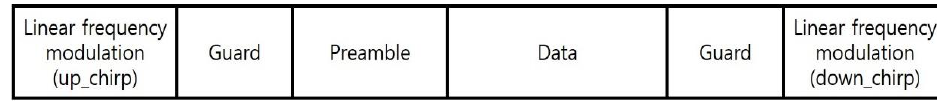
Figure 9. The Packet structure in the lake trial.